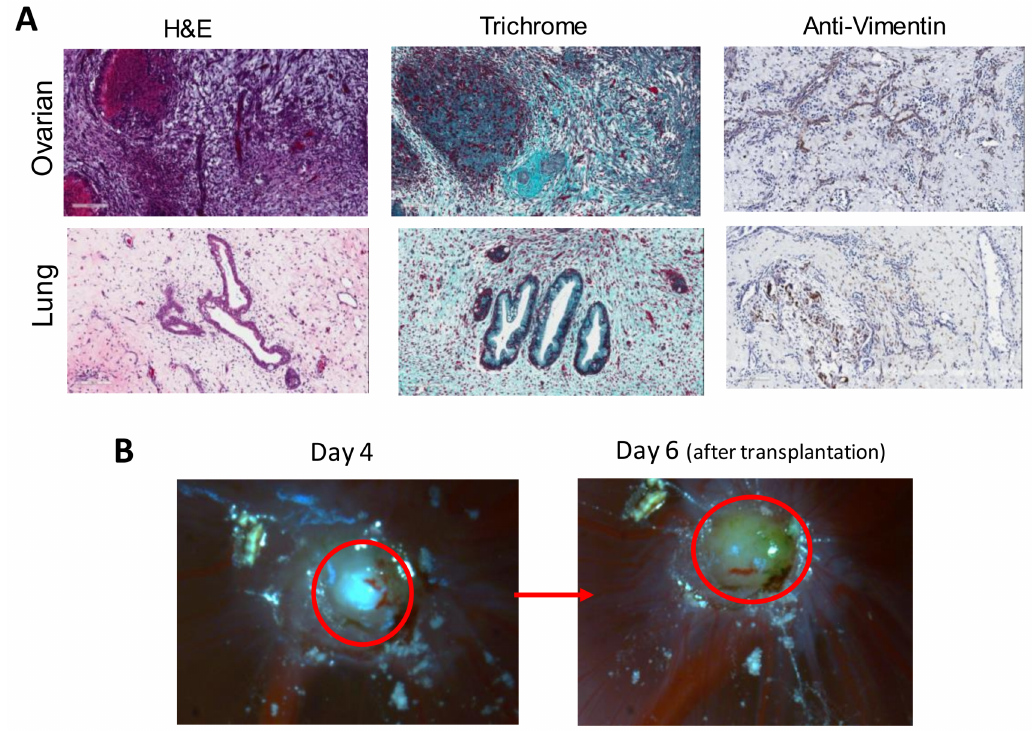
Figure 2. ( A ) H&E, trichrome and anti-vimentin staining of the thin section of CAM tumors formed by transplanting ovarian cancer cells OVCAR8 and lung cancer cells A549; and ( B ) ovarian cancer patient tumor was minced and transplanted onto the CAM membrane. Tumor growth was followed. Modified from Figure 2B and Figure 8A Vu et al.